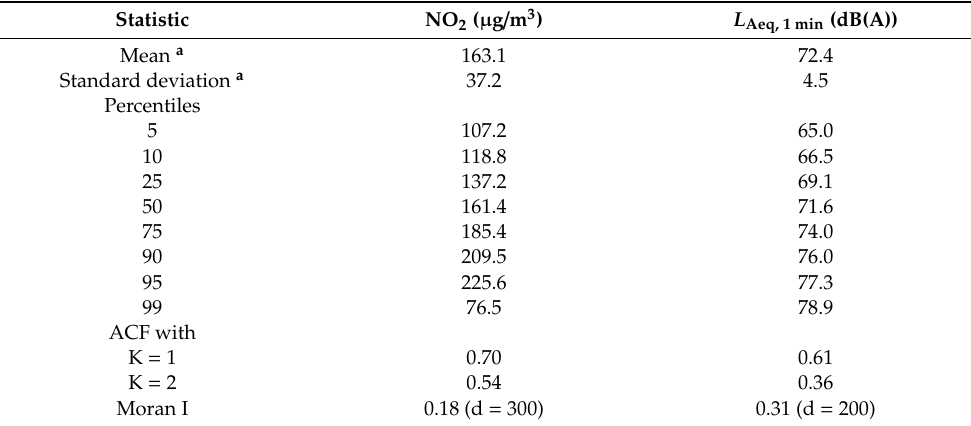
Table 2. Descriptive statistics for dependent variables.